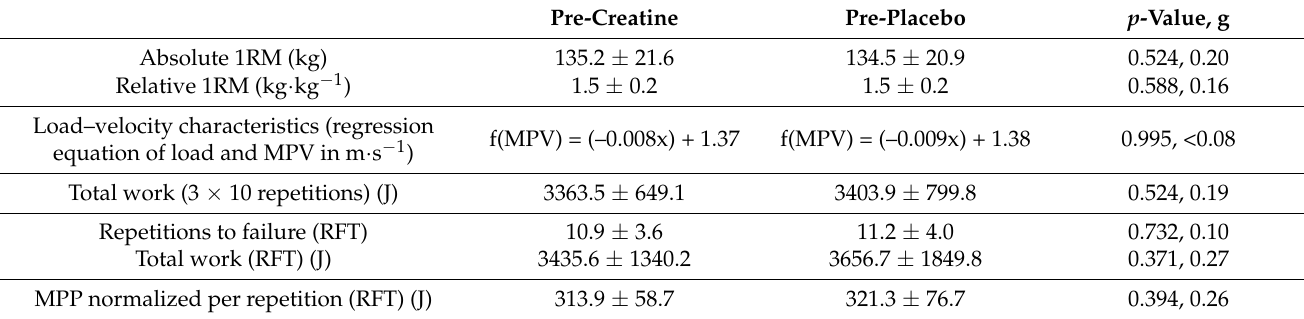
Table 1. Pre-test values for the randomized conditions. Values are presented as mean ± SD. 1RM = one repetition maximum; MPV = mean propulsive velocity; RFT = repetitions-to-failure test.